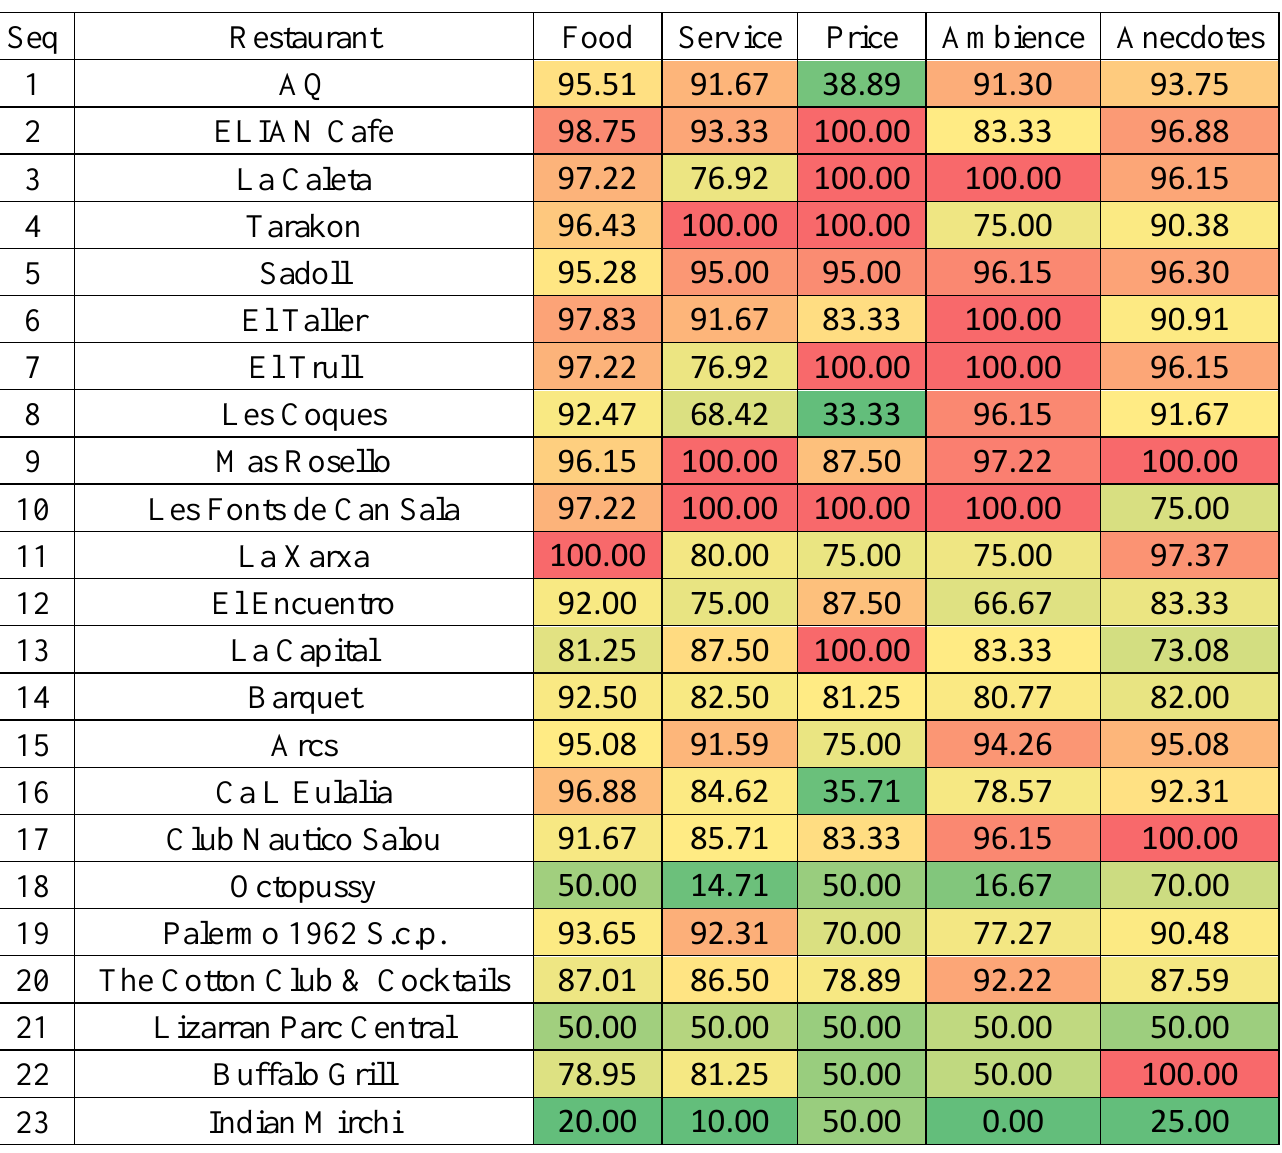
Figure 8. Example 1: social performance table. Colours have the same meanings as in the previous